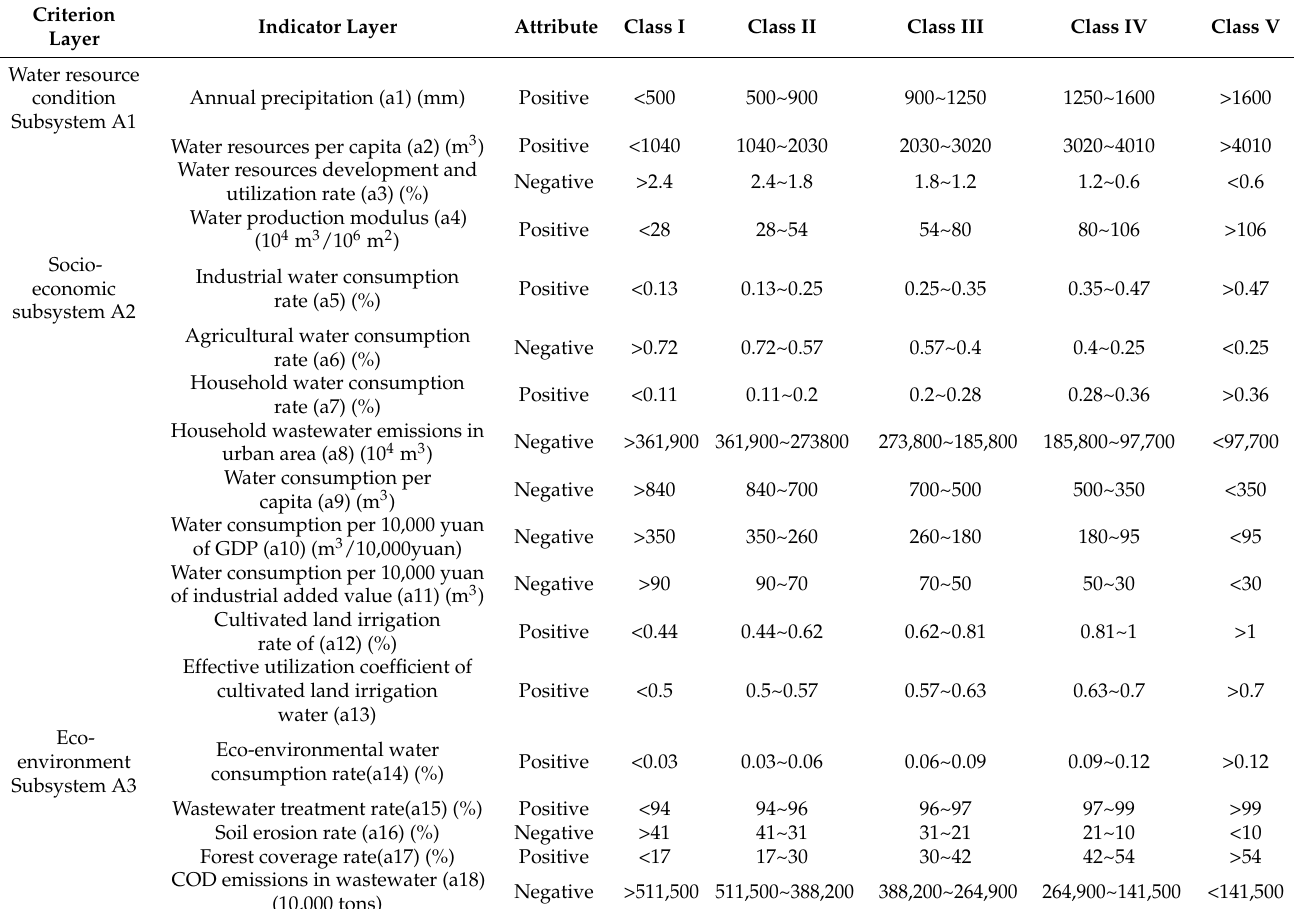
Table 1. The classification standards for sustainability assessment of water resources